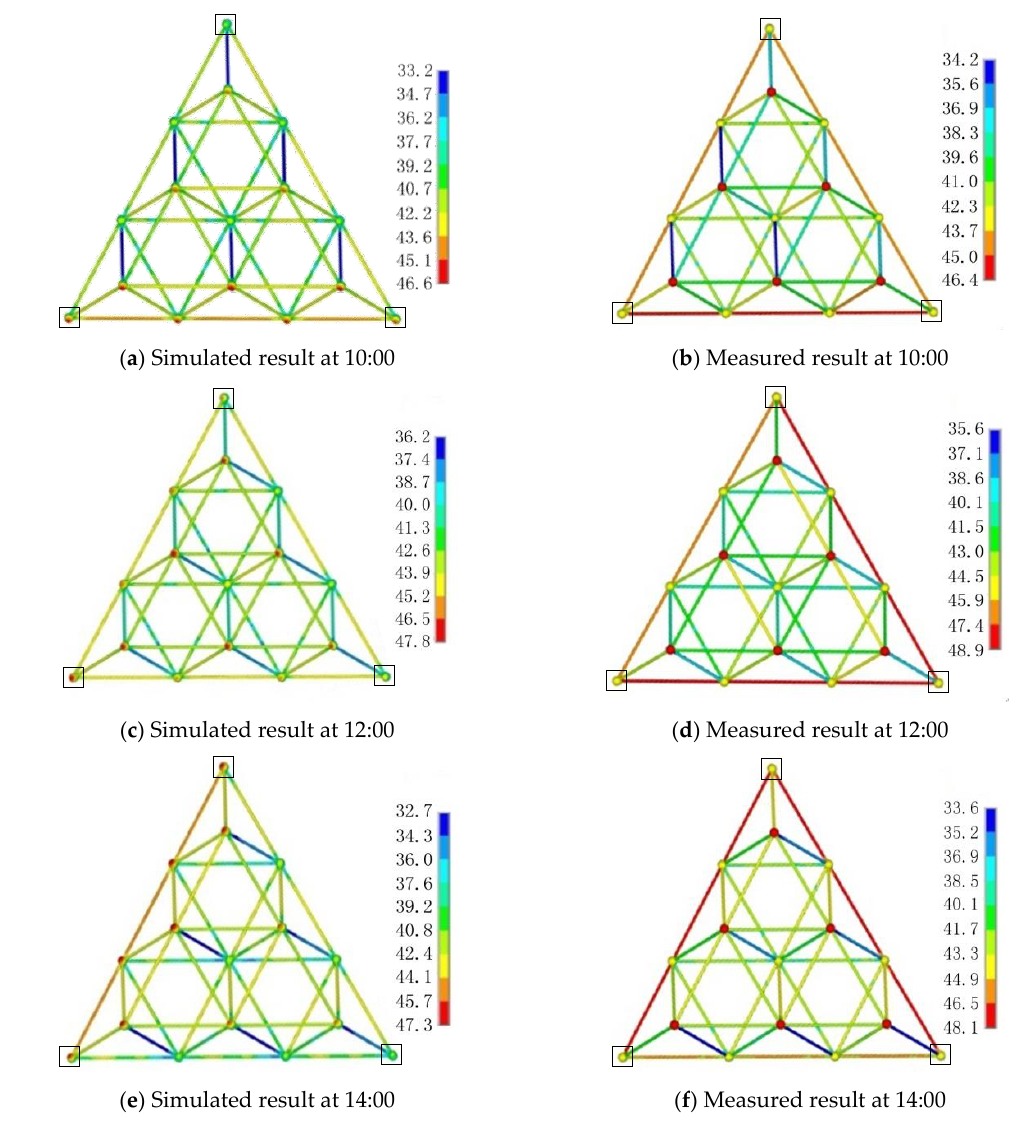
Figure 10. Temperature distribution of the spatial grid structure model. Black boxes indicate cross plate supports.